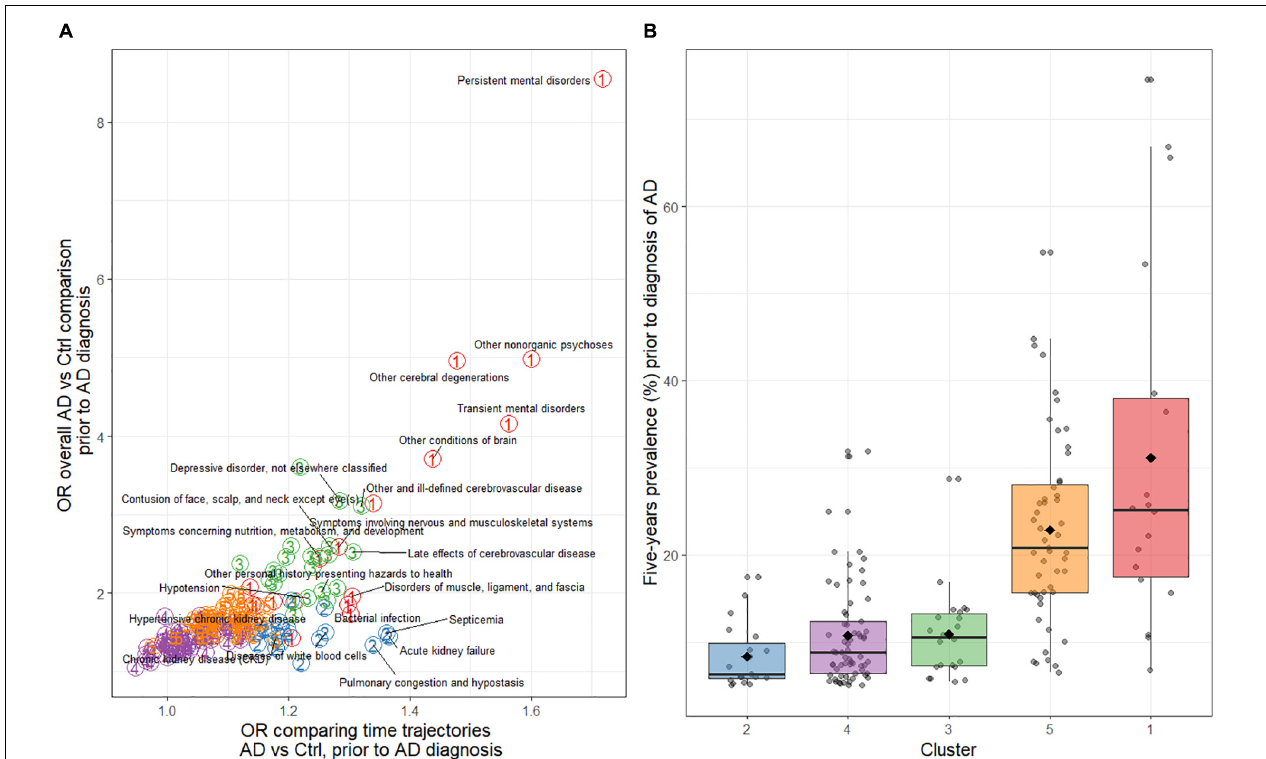
FIGURE 3 | (A) Odds ratios for the overall AD cases vs. non-AD controls comparison of comorbidities and for the time trajectories of comorbidities during the 5-year period before AD diagnosis. The colored circled numbers refer to the cluster that the comorbidity belongs to (i.e., red-colored 1 is cluster 1, etc.). (B) Distribution of the average comorbidity prevalence during the 5-year period before AD diagnosis by cluster. AD, Alzheimer’s disease; Ctr,